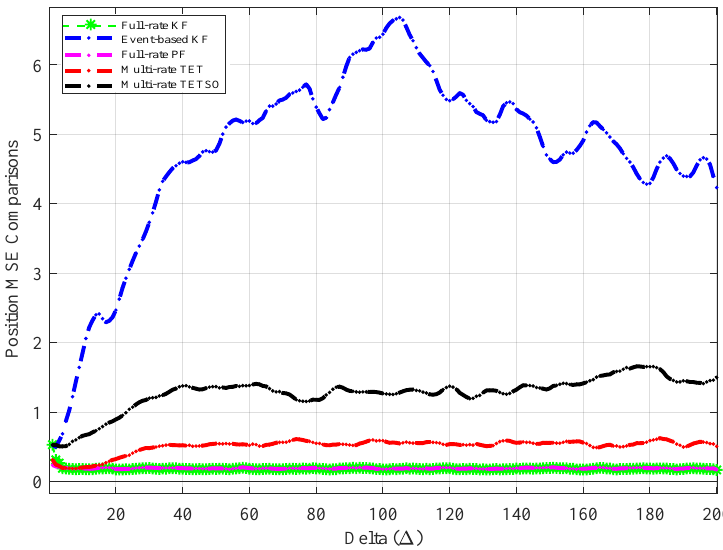
Figure 4. The MSE comparison across various values of the ∆ j , k